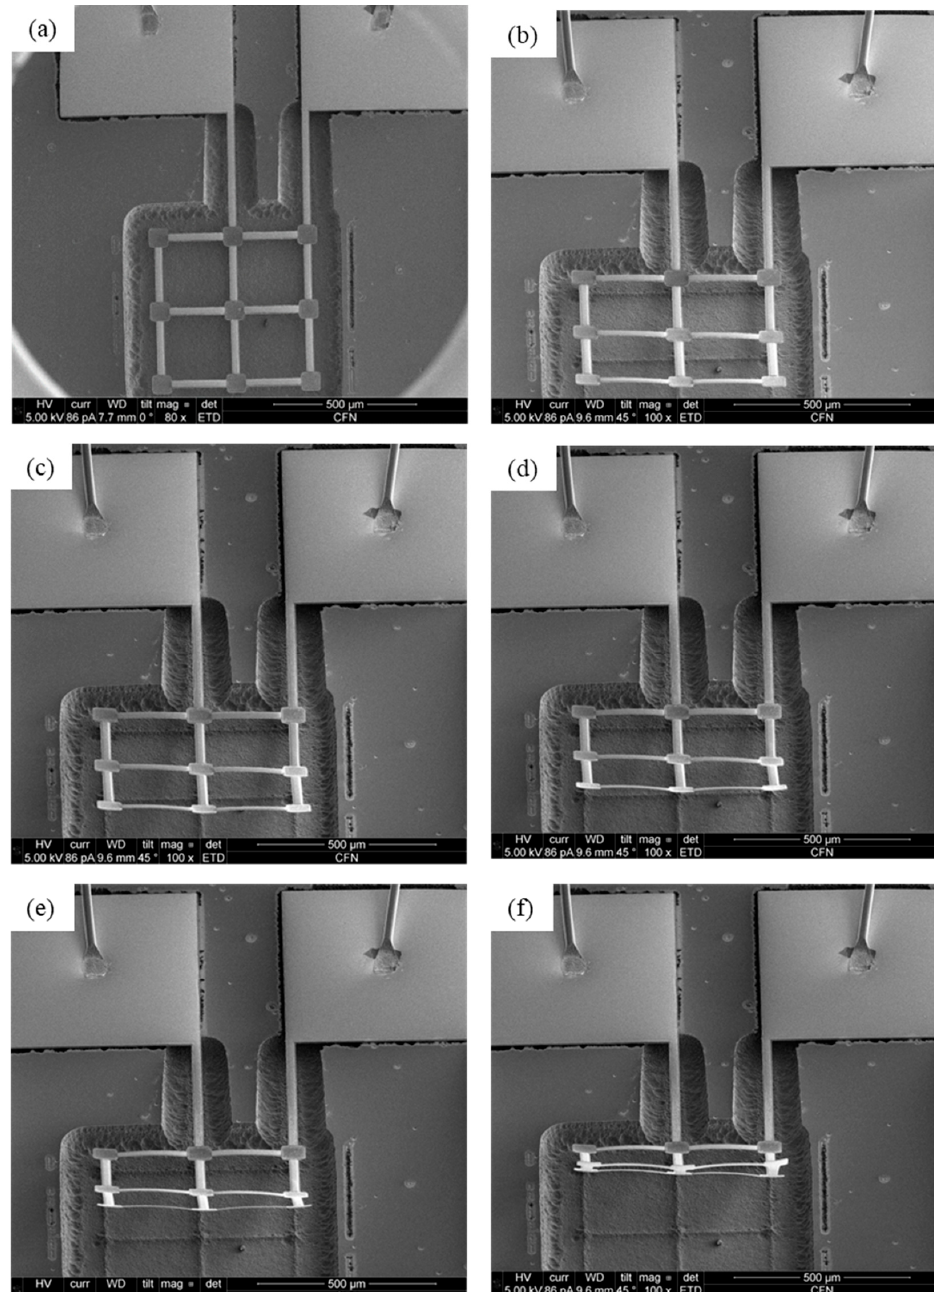
Figure 14. SEM images of bilayer solar sails under Joule heating with different driving voltages. ( a ) As-released bilayer solar sail without Joule heating; ( b ) SEM imaging with 45 ◦ tilt under 0 V; ( c ) Reconfiguration under 0.012 V; ( d ) Reconfiguration under 0.016 V; ( e ) Reconfiguration under 0.018 V; ( f ) Recon fi guration under 0.019 V.